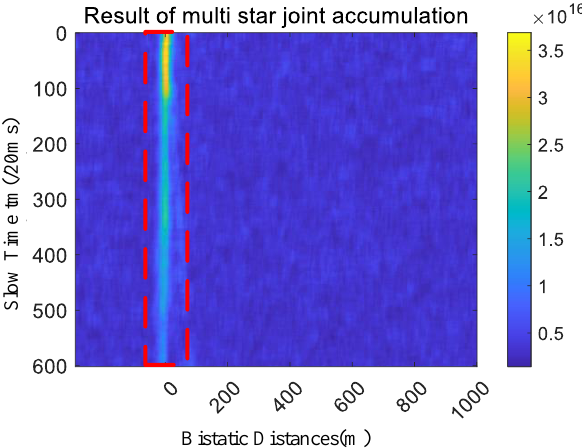
Figure 19. The target signal trajectory of the fusion of eight satellites. Table 4. Comparison before and after the combination of 8 satellite signals. Satellite Number